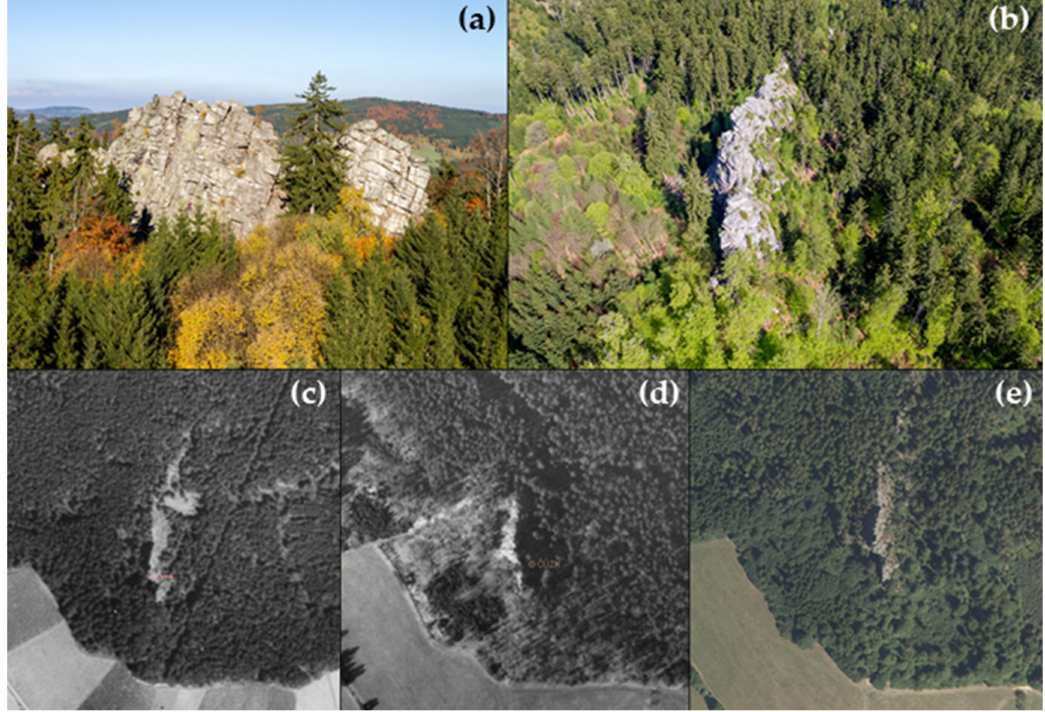
Figure 6. ( a,b ) Dr á tenick á sk á la aerial photography taken by an RC (remote control) micro-copter (author: Lubom í r Dajˇc, 2012), ( c ) historical orthophoto from 1953, ( d ) historical orthophoto from 1998, and ( e ) historical orthophoto from 2018